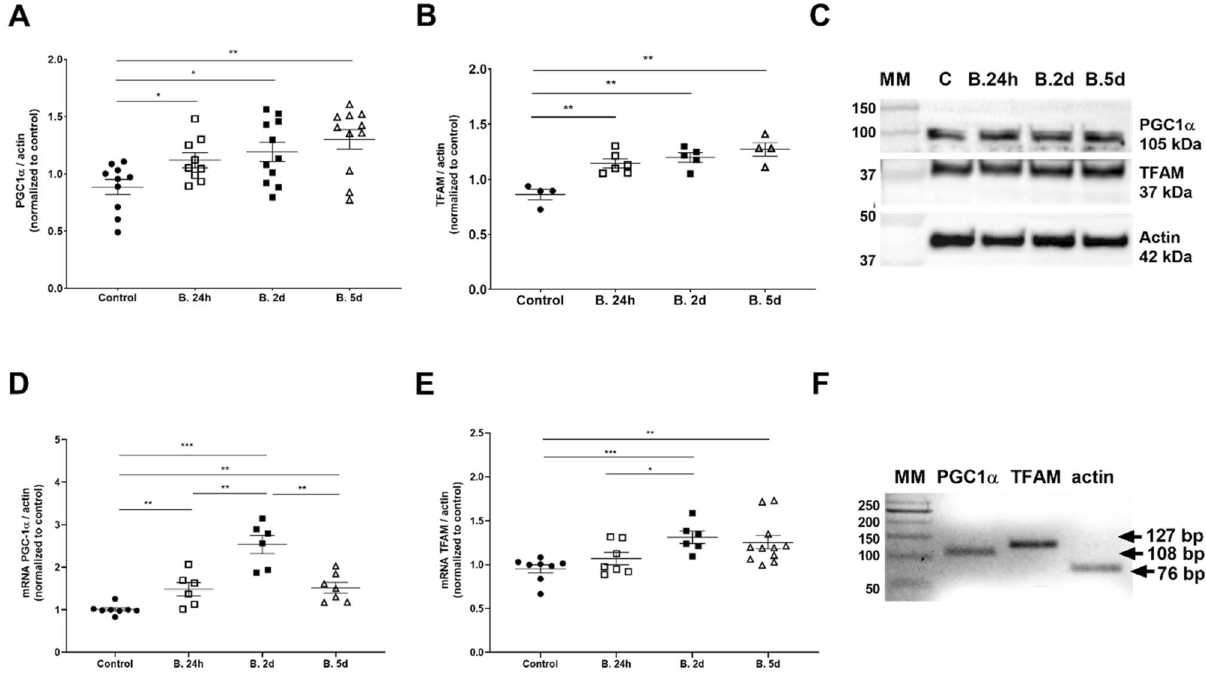
Figure 4. Mitochondrial biogenesis is enhanced in human podocytes after L-BAIBA treatment. ( A ) PGC-1α expression in podocytes that were cultured with and without L-BAIBA (10 µM; 24 h, 2 days, and 5 days). n = 9–11, * p < 0.05, ** p < 0.01. ( B ) TFAM expression in podocytes after L-BAIBA treatment. n = 4–6. ** p < 0.01. ( C ) Representative immunoblots for PGC-1α and TFAM. ( D ) PGC-1α mRNA expression in podocytes that were cultured with and without L-BAIBA. n = 6–8. ** p < 0.01, *** p < 0.001. ( E ) Effects of L-BAIBA on TFAM mRNA expression in podocytes. n = 6–11. * p < 0.05, ** p < 0.01, *** p < 0.001. ( F ) Representative agarose gel showing PCR products.